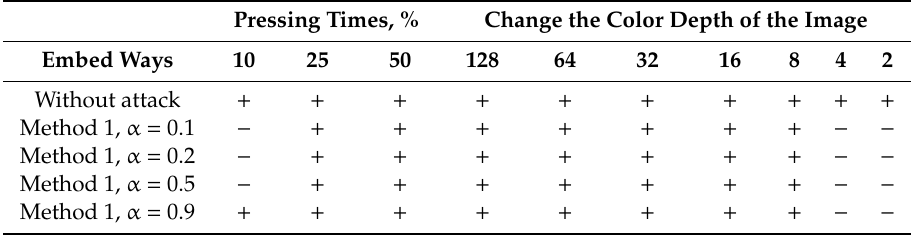
+ + + Method 4, α = 0.5 + + − − − + + Method 4, α = 0.9 Table 4. The results of the experiments carried out on the attacks to verify the e ff ectiveness of the method on the example of the test image “Lena” by Equation (34) for the parameters m = 1 / 3, n = 1. Pressing Times, % Change the Color Depth of the Image Embed Ways 10 25 50 128 64 32 16 8 4 2 Without attack + + + + + + + + + + Method 1, α = 0.1 − + + + + + + + − − Method 1, α = 0.2 − + + + + + + + − − Method 1, α = 0.5 − + + + + − − Method 1, α = 0.9 + + + + + + + + −